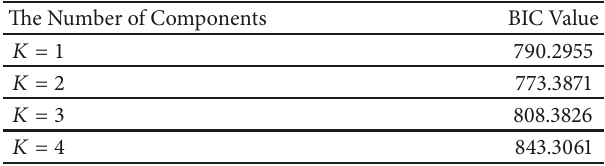
Table 4: BIC value of FMLR